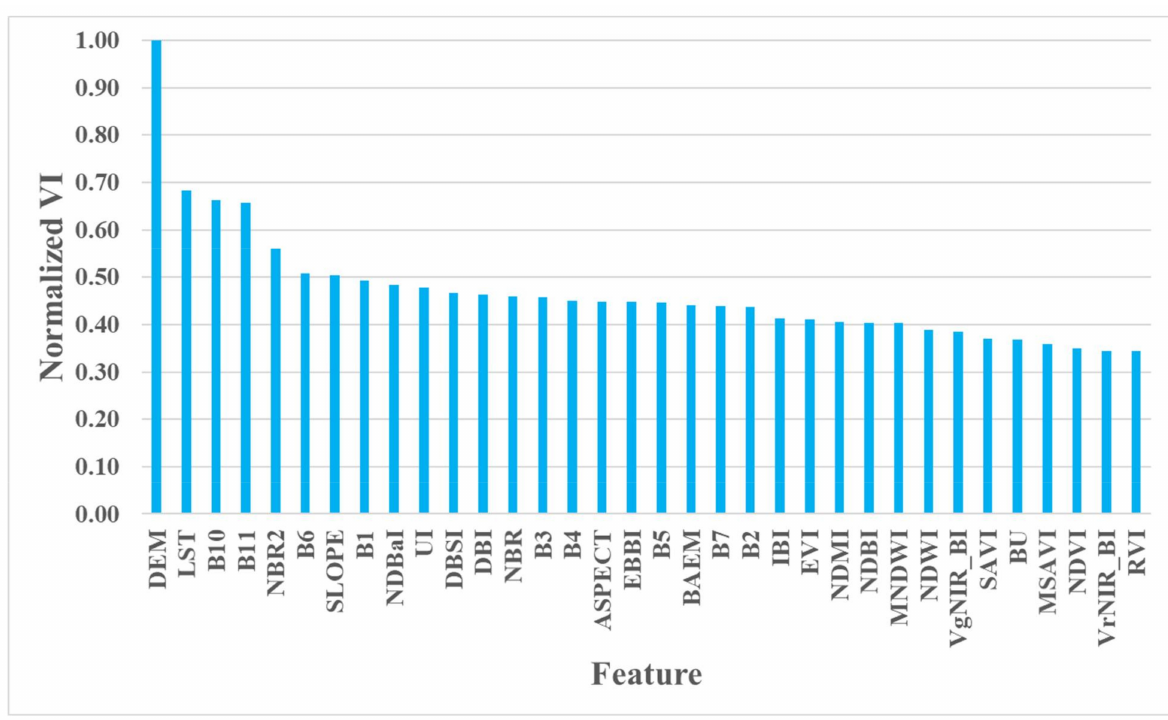
Figure 5. LULC map results: ( a ) 1985; ( b ) 1993; ( c ) 2000; ( d ) 2008; ( e ) 2013; ( f ) 2019.